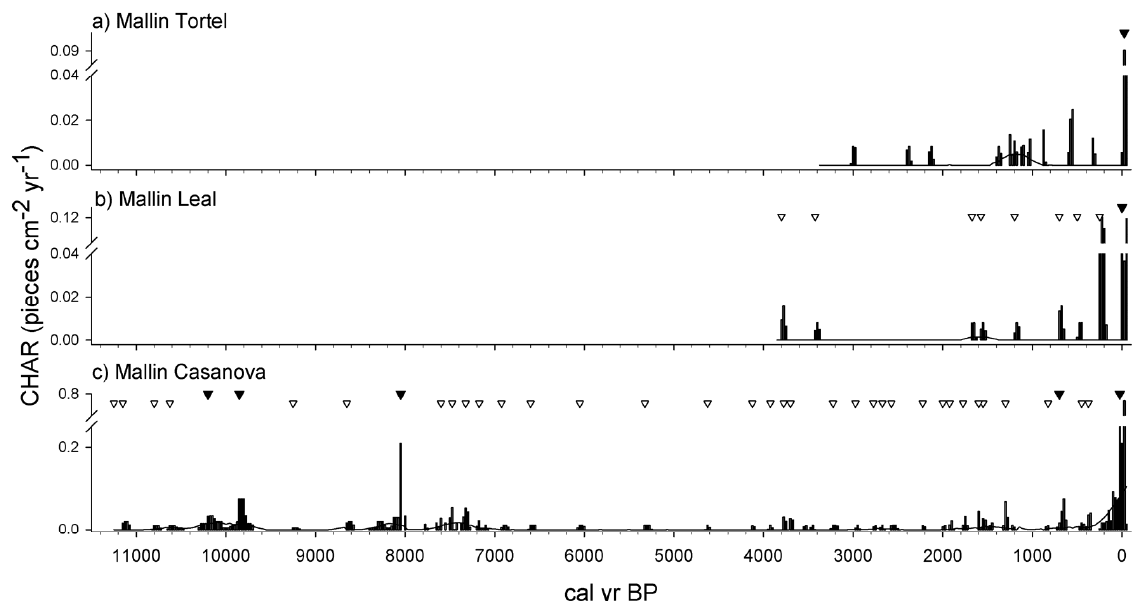
Fig. 4. Charcoal peak analysis using CharAnalysis (Higuera et al., 2009). Charcoal accumulation rates (CHAR piecescm − 2 yr − 1 ) are plotted on an age axis and interpolated to 25yr intervals. Background charcoal (black line) defined by 1000-yr trends. In order to separate charcoal peaks from the background noise, we used a Gaussian mixture model to estimate the mean and variance of the noise distribution. Fire events were identified as peaks exceeding the 99th percentile of the noise distribution. ( P > 0.05, white inverted triangles; P < 0.001, solid black inverted